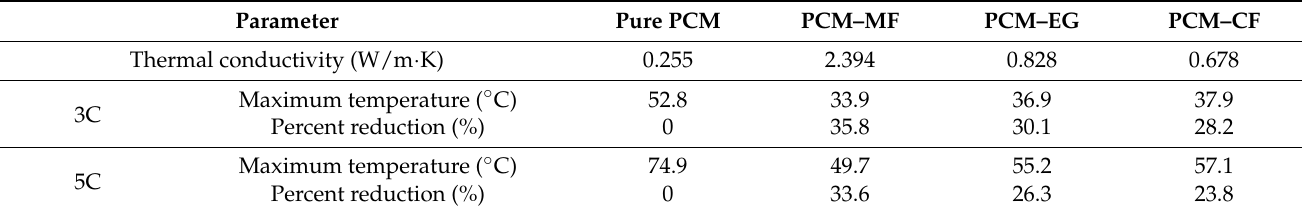
Figure 11. Battery temperature with various PCM composites at: ( a ) the 3C discharge rate; ( b ) the 5C discharge rate (1: sensible heating of solid; 2: latent heat of fusion; 3: sensible heating of liquid). Table 5. Specifications of PCM composites and their